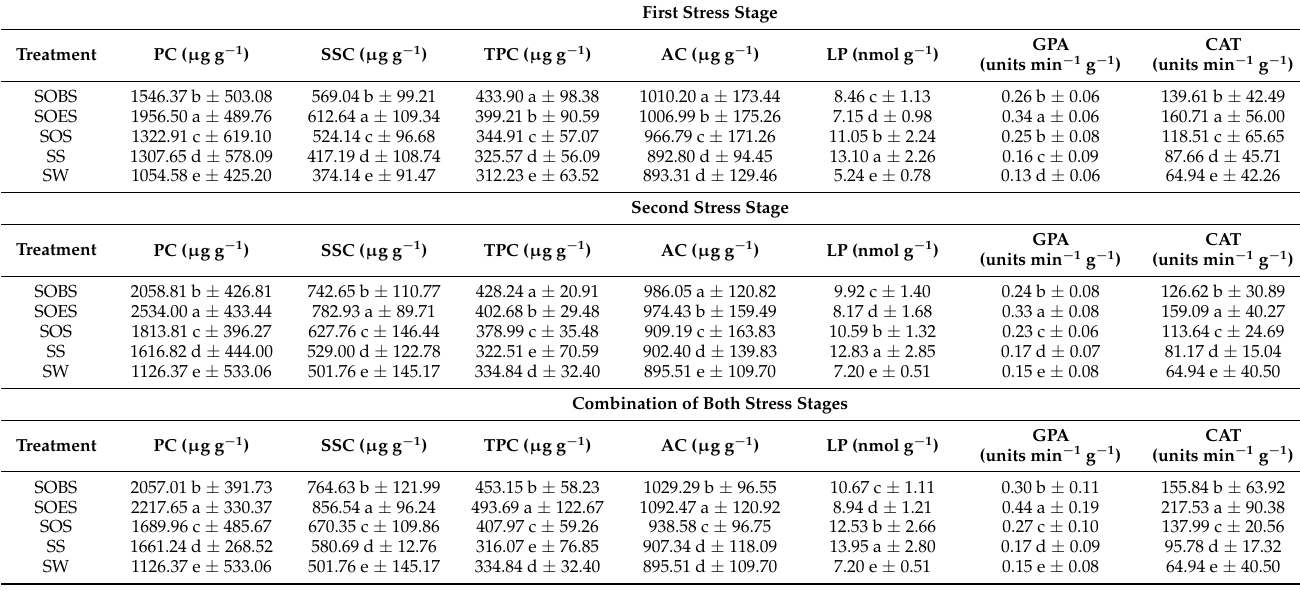
Table 5. Impact of oak leaf powder, oak leaf extract, and biofertilizer on the biochemical characteristics of the leaves of tomato plants under various stress